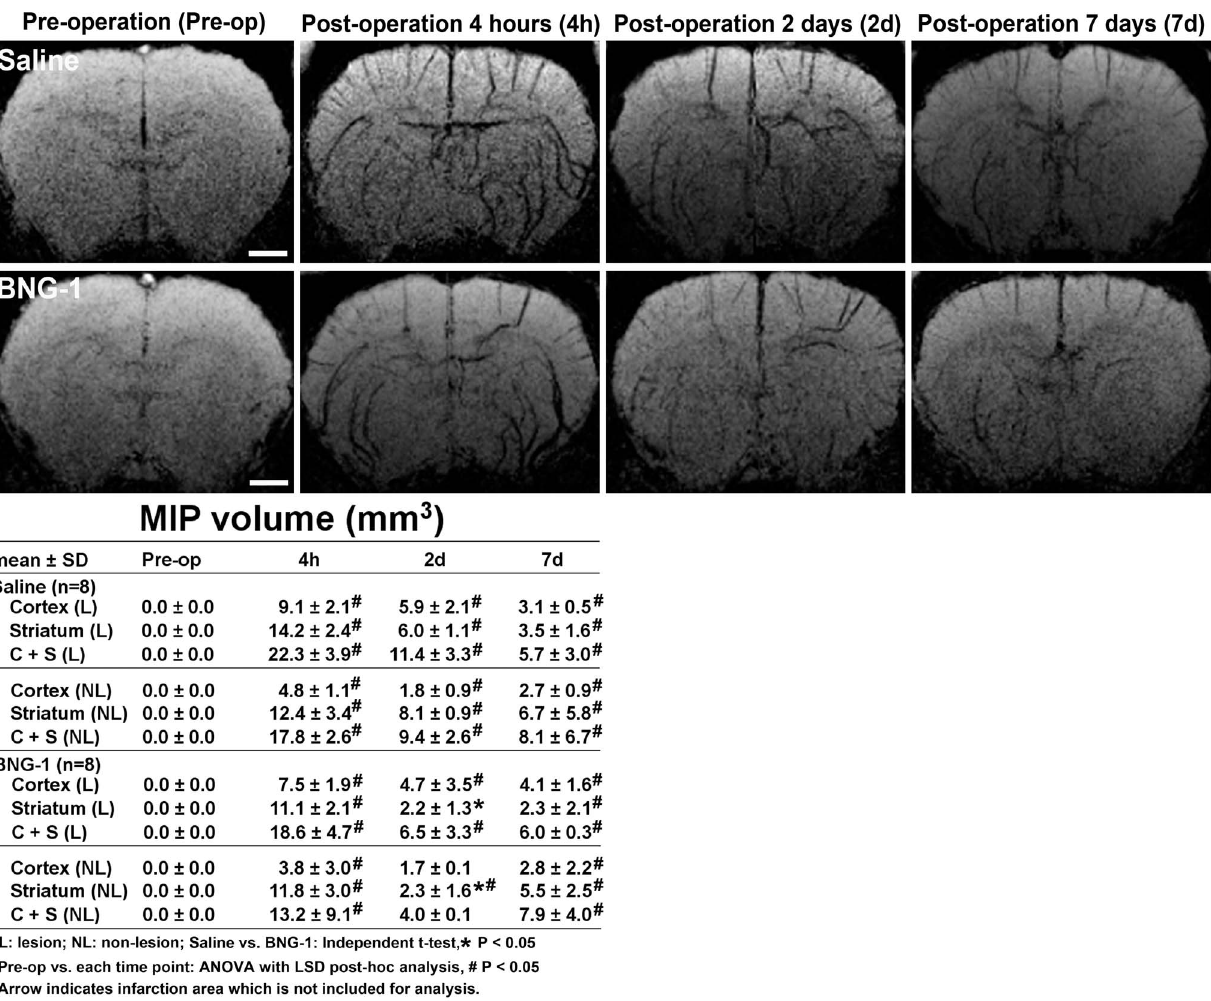
Fig. 4. Comparison of the temporal changes in the maximal intensity projection after focal cerebral ischemia between the saline and BNG-1 treatments. The maximal intensity projection of the SWI indicates that the volume of the low signal intensity (cerebral vessels) is smaller in the BNG-1 group than the saline group in the striatum of both lesion and non-lesion hemispheres at 2 d. The bar in the pre-operation panels indicates 2.5